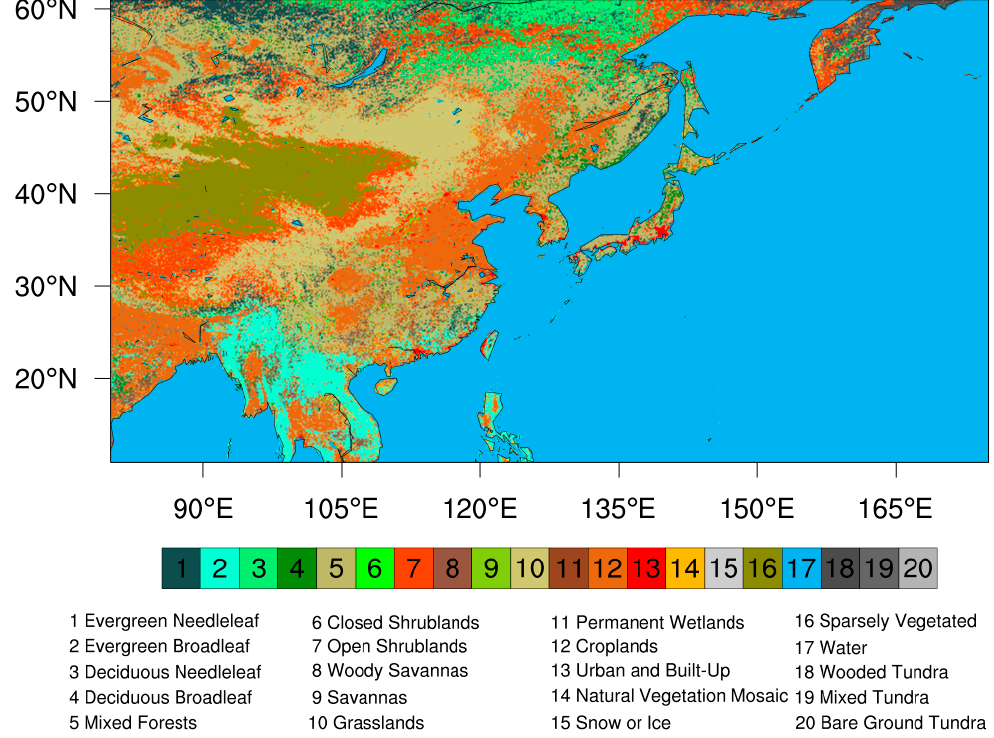
Figure 1. Landcover information within the research area (Data source: MODIS-IGBP 21 class LULC data [22]).